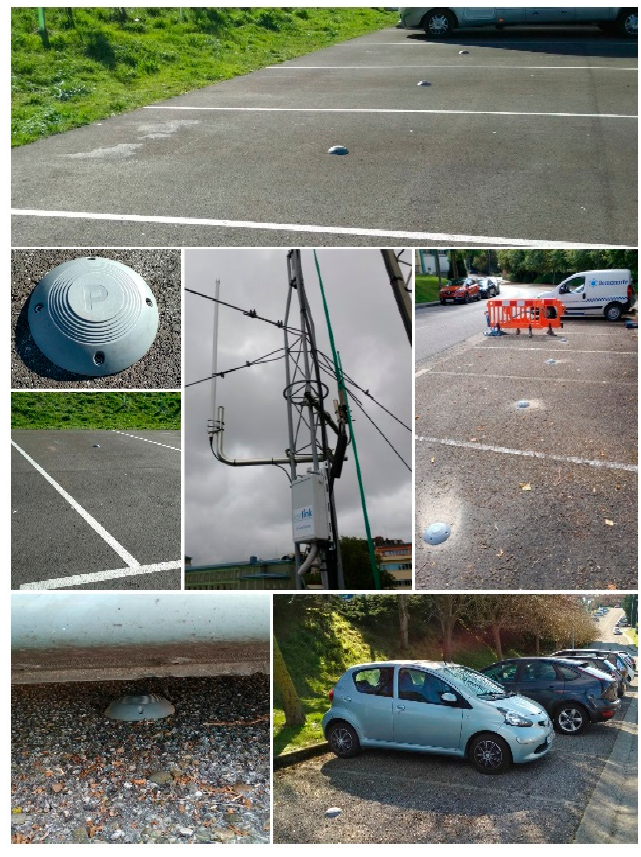
Figure 7. LoRa deployment examples in the city of Santander.